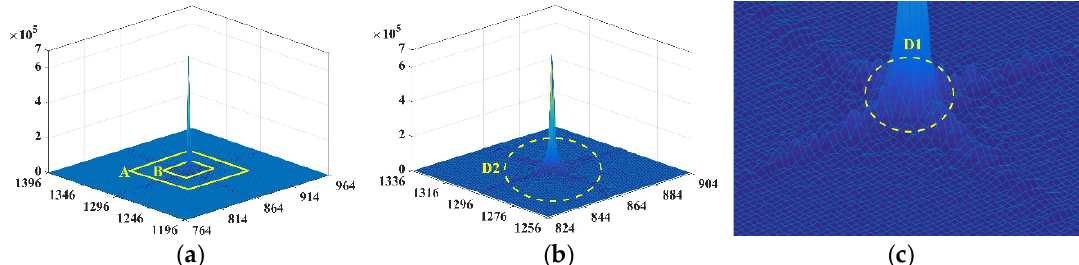
Figure 4. The frequency domain amplitude spectrum visualized in 3D: ( a ) the amplitude distribution of the local regions in the frequency domain; ( b ) a partial enlarged image of region A in ( a ) (the high-frequency region is depicted beyond the yellow ellipse D 2 ); and ( c ) a partial enlarged image of region B in ( a ) (the low-frequency region is displayed within the yellow ellipse D 1